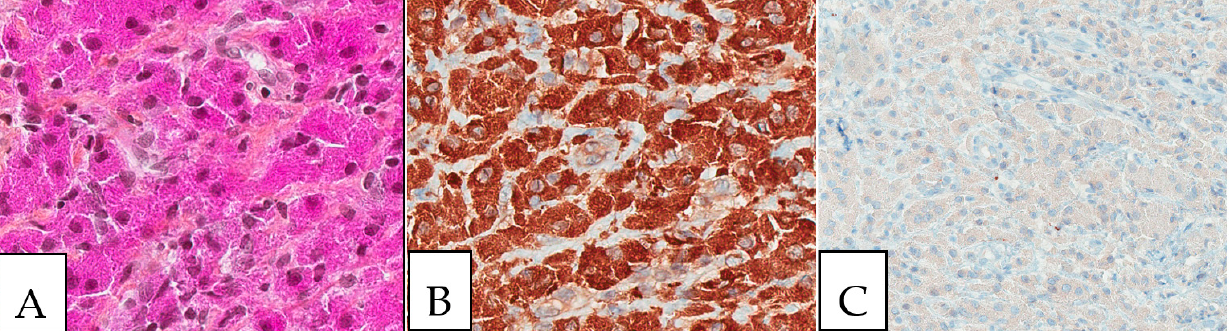
Figure 2. Crystal storing histiocytosis. ( A ) Morphology of samples affected by crystal-storing histiocytosis, ( B ) CD68-positive histiocytes, ( C ) S100-negative lesion. This specimen is from the same patient described in Figure 1 ( A ) and was taken from a colonic white mucosal elevation.